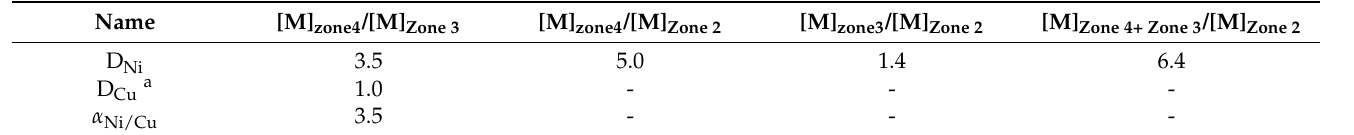
Table 1. Distribution ratios and separation factors of Ni and Cu in ionic liquid phase (zone 3 and zone 4) and aqueous phase (zone 2).